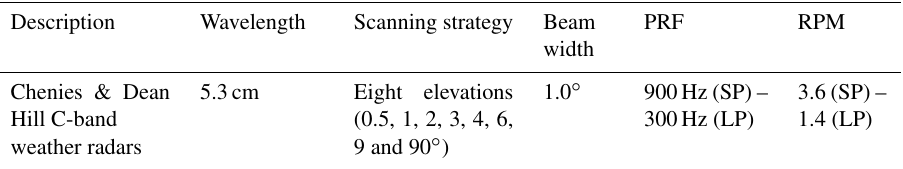
Table 1. Polarimetric radar characteristics.